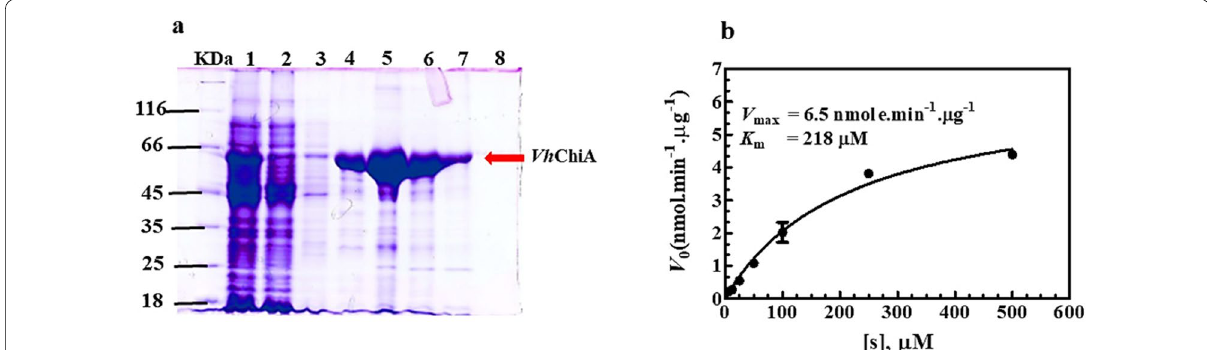
Fig. 1 Expression, purification and chitinase activity determination of Vh ChiA. a SDS-PAGE analysis. Vh ChiA was eluted from a Ni–NTA agarose affinity column with 150 mM imidazole in the equilibration buffer and its purity was assessed by 12% SDS-PAGE. kDa, protein markers; Lane 1, crude extract; 2, unbound fraction; 3, fraction washed with the equilibration buffer; 4–7, fractions eluted with 150 mM imidazole; 8, last fraction washed with the equilibration buffer. b Michaelis–Menten plot of the initial rate ( v 0 ) vs. p NP-(GlcNAc) 2 concentration